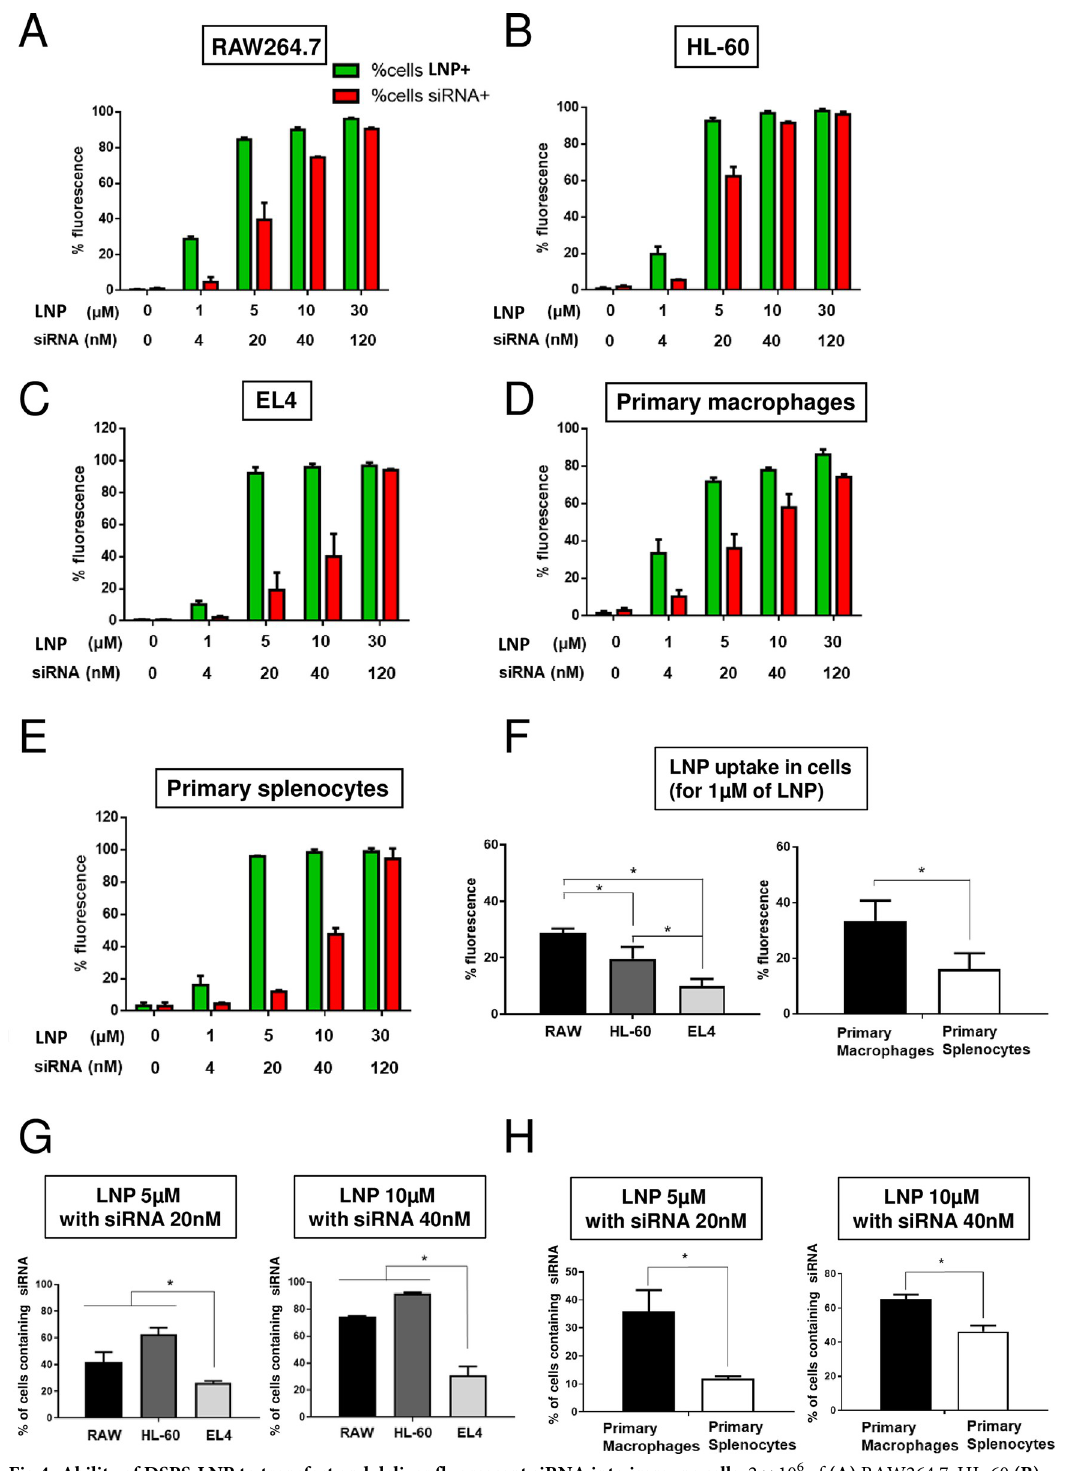
Fig 4. Ability of DSPS-LNP to transfect and deliver fluorescent siRNA into immune cells. 2 × 10 6 of (A) RAW264.7, HL-60 (B) , and EL4 cells (C) , or primary macrophages (D) or splenocytes (E) , were seeded in 6-well plates in DMEM containing 10% FBS. On the next day, cells were treated/nontreated with 1 ml LNP-S60 (green fluorescent probe Bodipy-FL) at different concentrations containing fluorescent siRNA (red fluorescent probe cyanine-3) at 37˚C in DMEM medium with 10% FBS. The percentage of Bodipy-FL and cyanin-3 positive cells were analyzed by flow cytometry. (F) LNP uptake (using 1 μ M of LNP) was measured in